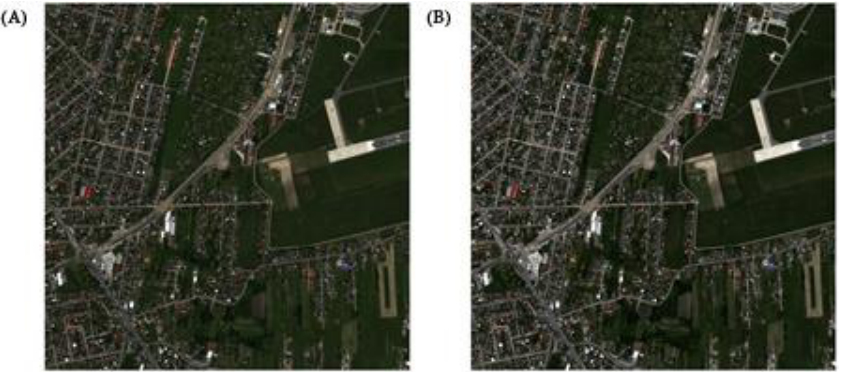
Figure 9. Sample test image — fragment of a multi-spectral image captured by the World View-2 satellite, depicting the suburbs of the town of Radom: ( A ) low-resolution (LR) image (dimensions: 917 × 921 pixels), ( B ) high-resolution (reference) image obtained as a result of pansharpening with the Gram – Schmidt method (dimensions: 3667 × 3684 pixels).